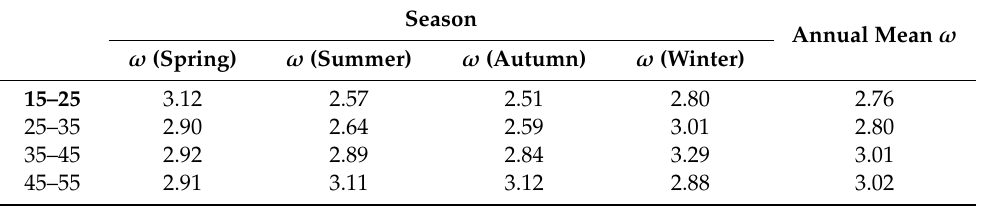
Table 2. Summary of the empirical values of coe ffi cient ω in China across di ff erent latitudinal